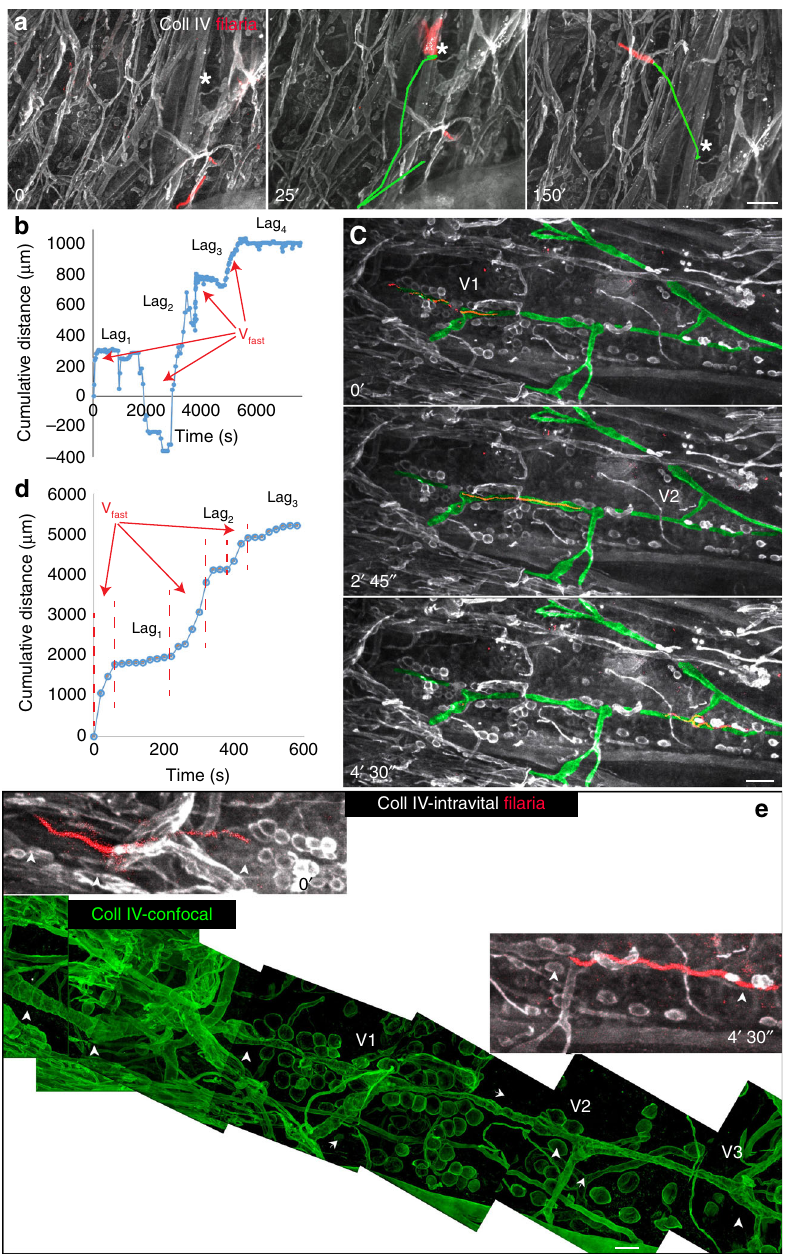
Fig. 2 Different modes of fi lariae migration in dermis and within lymphatics. Intravital imaging of live-labeled fi lariae in the tissue stained for collagen IV (Coll IV). a , b Filaria migration in the dermis. a Filaria displays a discrete pattern of migration in the interstitium. Image sequence of 12-h tissue probing by larvae migrating within the dermis (Supplementary Movie 7). The periods of negligible migratory progress were interleaved with rapid bursts of migration. * , tissue reference point; green lines, migration paths from the preceding time point (shown in the middle image). b A graph showing the biphasic migratory pattern, and the directionality of fi lariae migration within the dermis interstitium. The net migration took place during migratory bursts (arrows), but larva spent most of the time in backward – forward movements (migratory lags). c , d Filaria migration in lymphatics. c Biphasic and unidirectional migration of fi laria in lymphatics. A 13-min image sequence of the fi laria larva migrating within the lymphatic collector (Supplementary Movie 9). The system of lymphatic collectors is marked by the green mask manually painted over the image. V a1 and V a2 mark locations of valves where a fi laria paused its migration. d A graph showing the speed and the unidirectionality of fi laria migration inside the lymphatic collector. Migratory bursts (arrows, V lymph = 731 µ m/min) were interleaved by equal migratory lags. Source data are provided as a Source Data fi le. e Confocal imaging of the reconstructed migratory path revealed that intralymphatic migration of larva was delayed only at complex lymphatic junctions (V1 – V2). Arrowheads point to all valves of the collector. White, images from the intravital imaging with the fl uorescence stereomicroscope that preceded fi xation and subsequent confocal imaging (maximum intensity projections, green) of the same skin fragment. Tracking of movement of a single fi laria in the dermis ( b ) and in lymphatics ( d ) (source data are provided as Source data fi le). Scale bars 100 µ